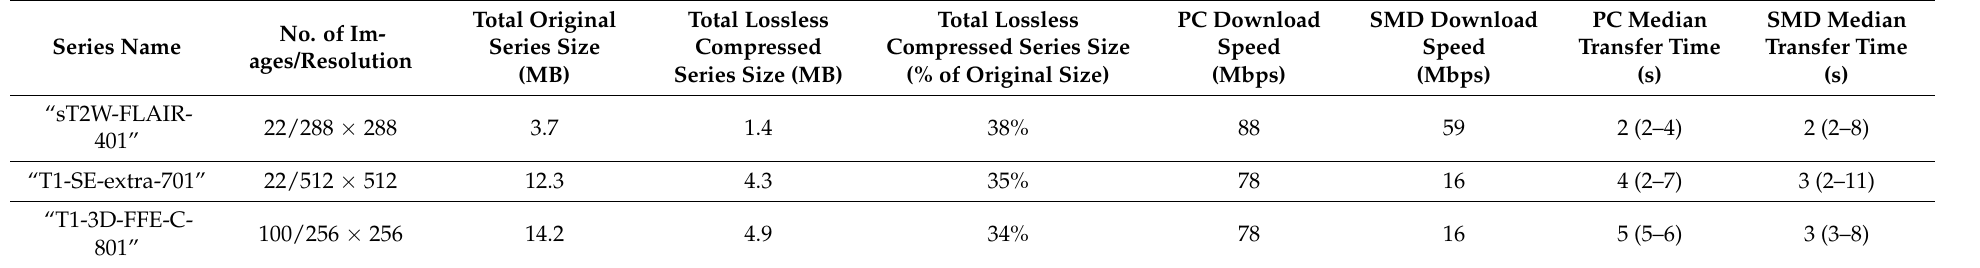
Table 2. Baseline transfer times for standard image sets using lossless